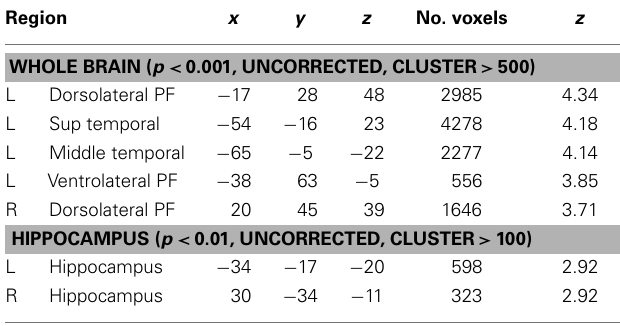
Table 1 | Brain – associative memory